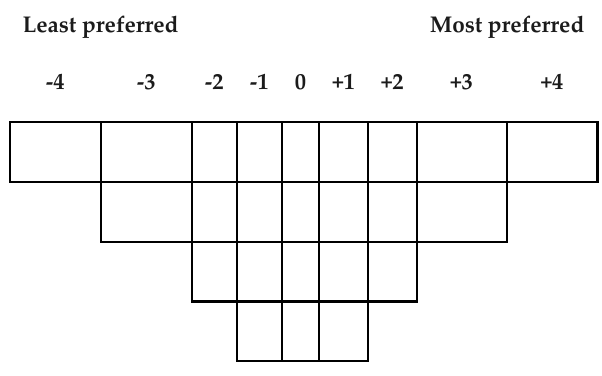
Figure 2. A q-sorting grid for an experiment with 24 stimuli (or items).